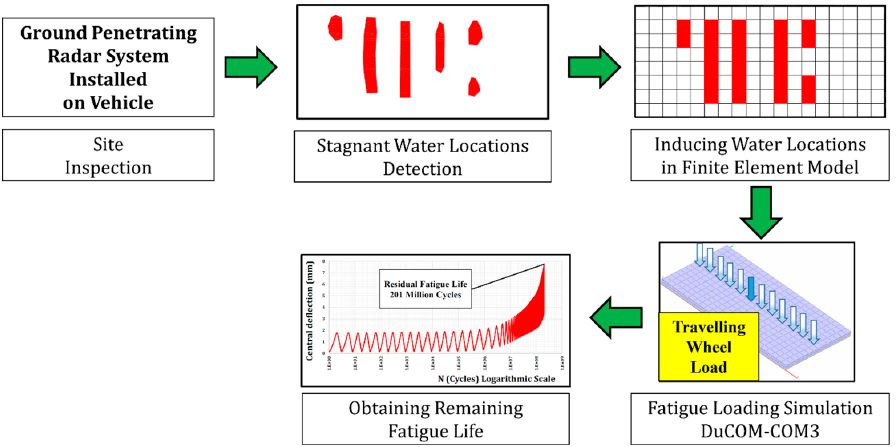
Figure 2. Overview of remaining fatigue life prediction methodology.